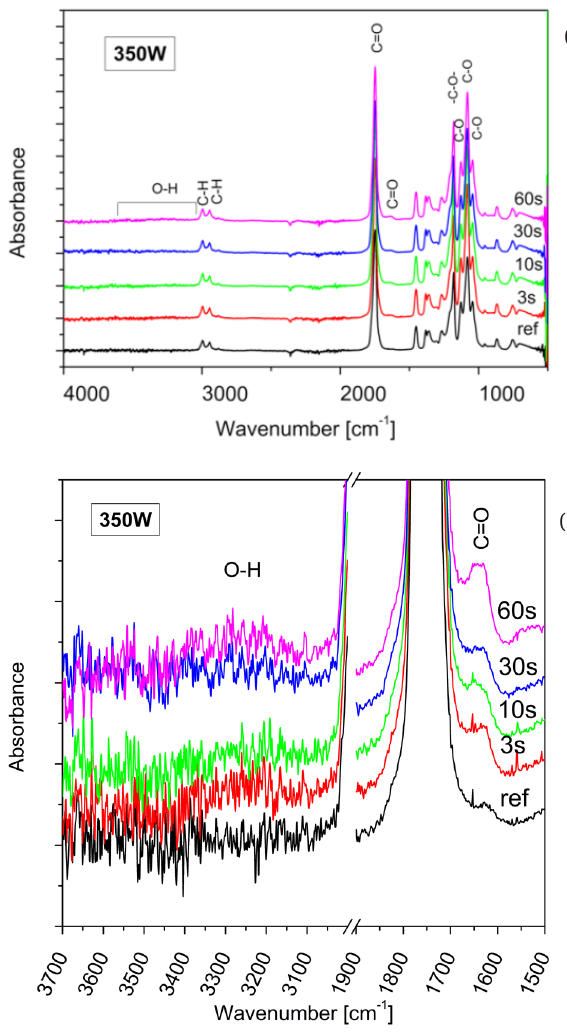
Figure 4 : ATR-FTIR spectra of PLA samples.